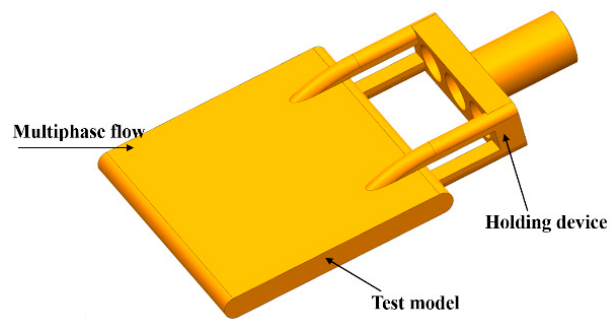
Figure 5. Three-dimensional maps of the test model and its fixing holder.